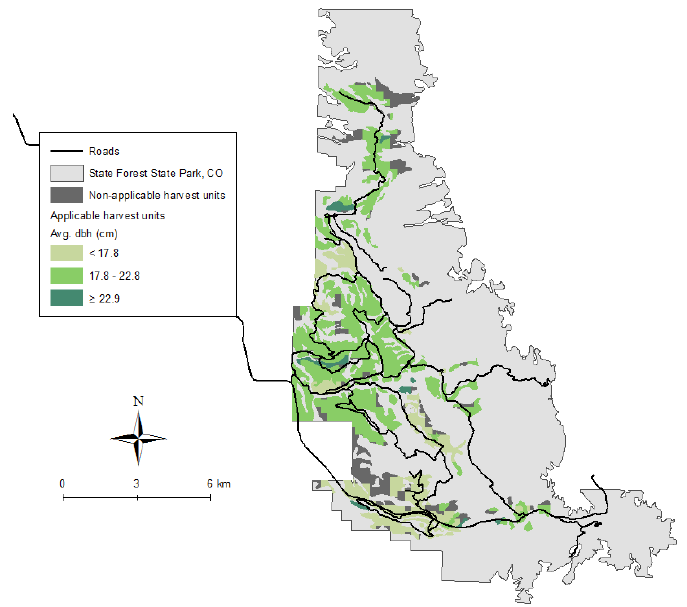
Figure 3. Harvestable lodgepole pine stands in the Colorado State Forest State Park using ground-based equipment shown in diameter at breast height (dbh) classes.